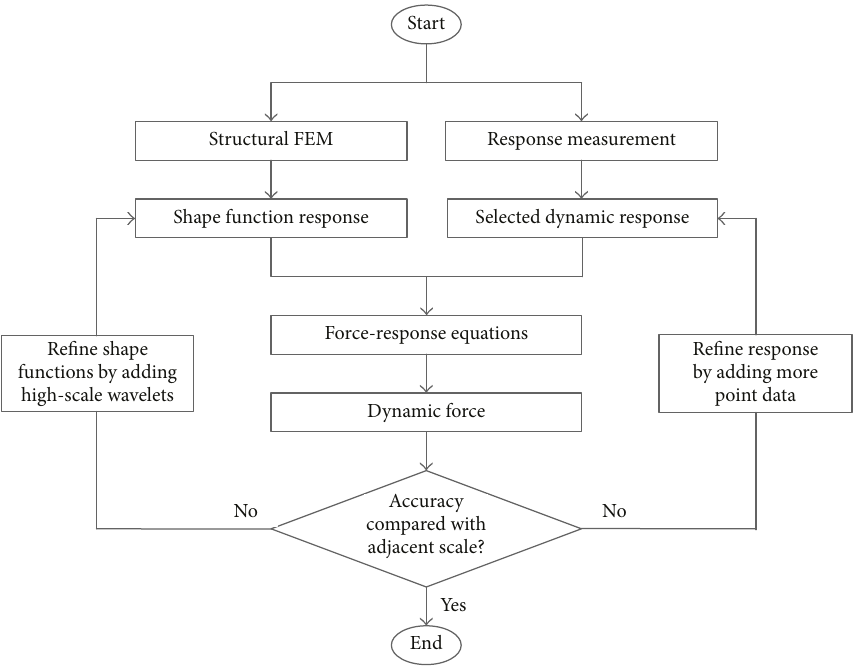
Figure 2: Diagram of the adaptive force reconstruction